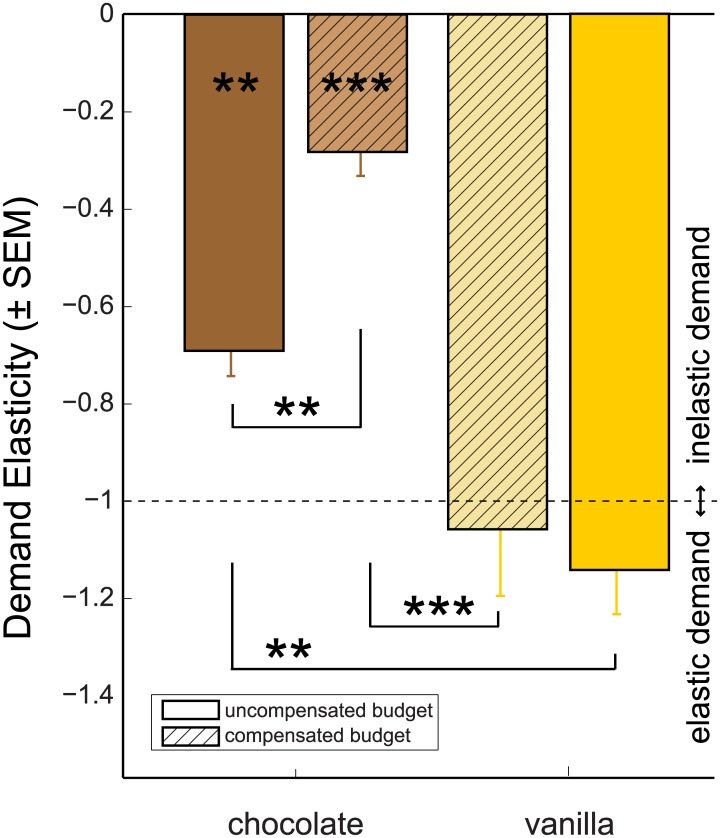
Demand elasticity (ε) for chocolate and vanilla solutions Group averaged elasticity estimates (±SEM) calculated per rat using averaged choice data across all sessions, separated per condition.Demand elasticity for chocolate (brown) was significantly less elastic than unit elasticity (ε = -1) under uncompensated (open bars; **: p<0.01, one-sample t-test vs. -1) and compensated budgets (hatched bars, ***: p<0.001). Demand was significantly less elastic for compensated vs. uncompensated budget conditions (**: p<0.01, paired-sample t-test). For vanilla (yellow), demand was significantly more elastic than for chocolate, both in the uncompensated (**: p<0.01, paired-sample t-test) and uncompensated budget condition (***: p<0.001).